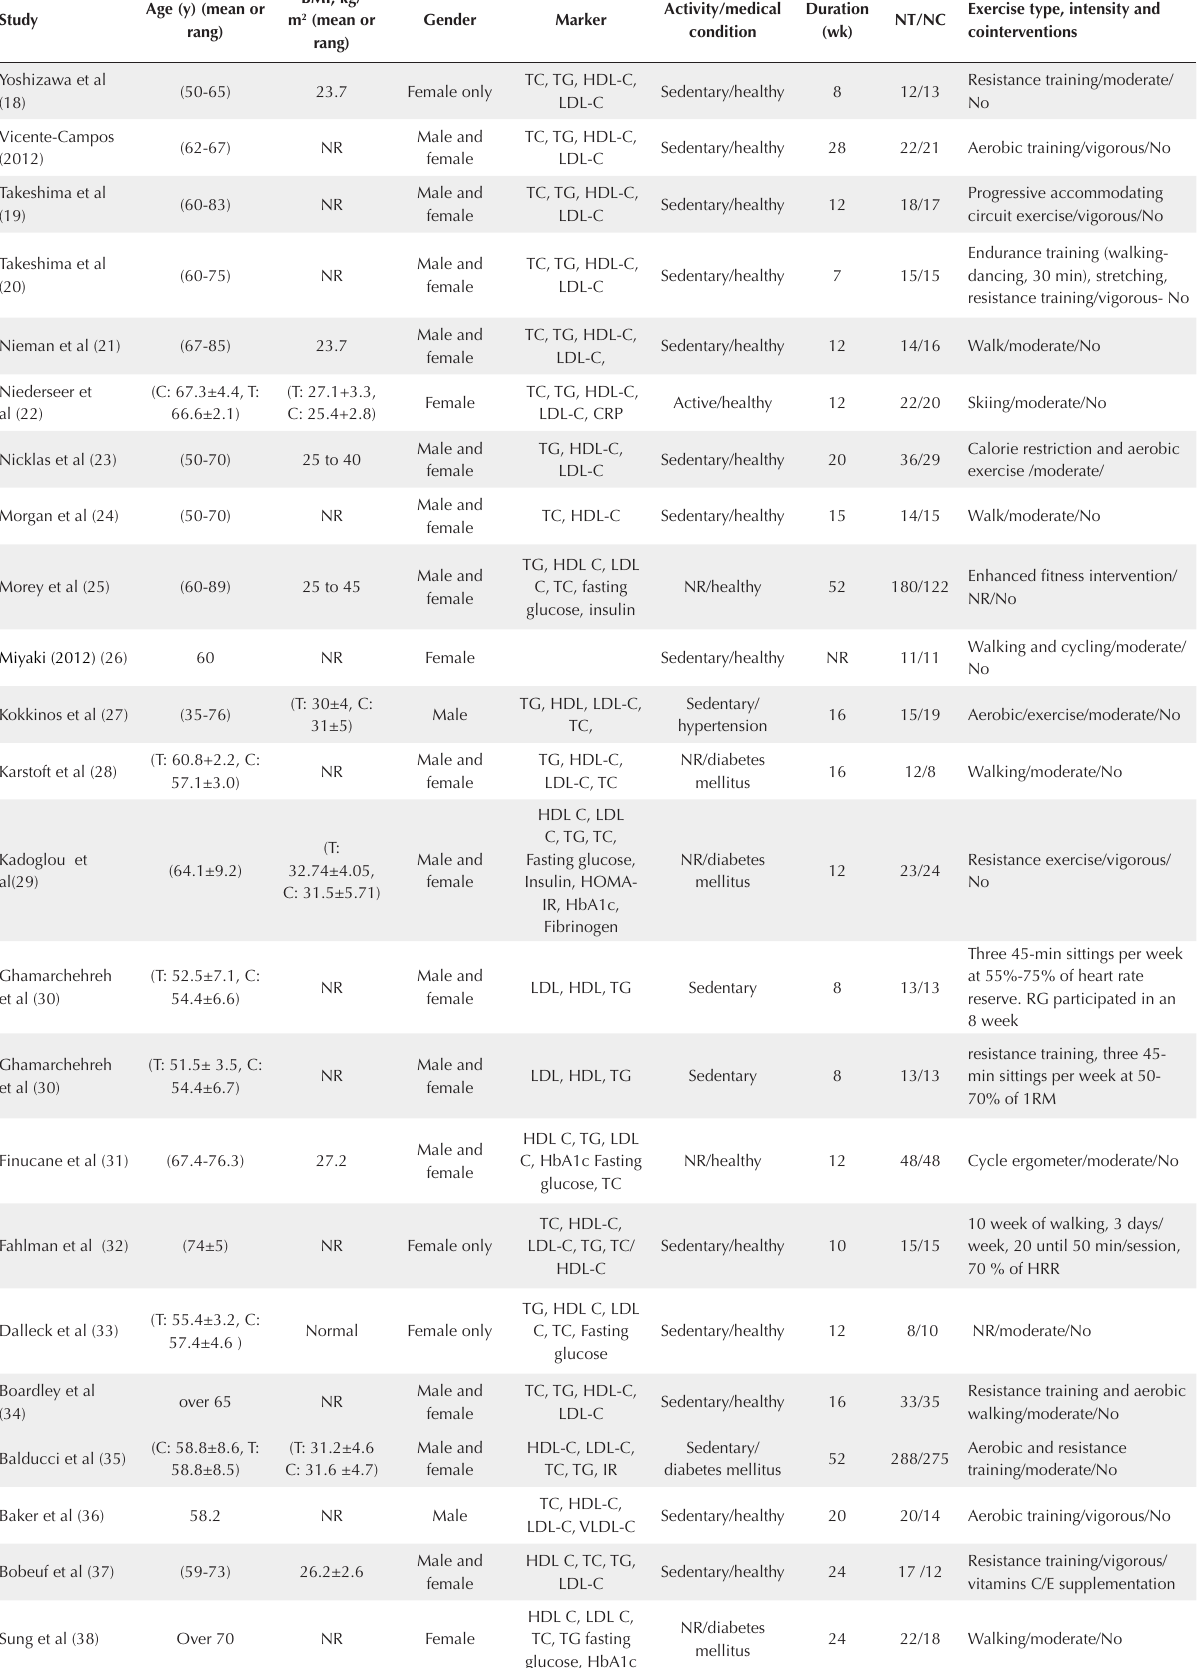
Table 1. Characteristics of the Included Studies